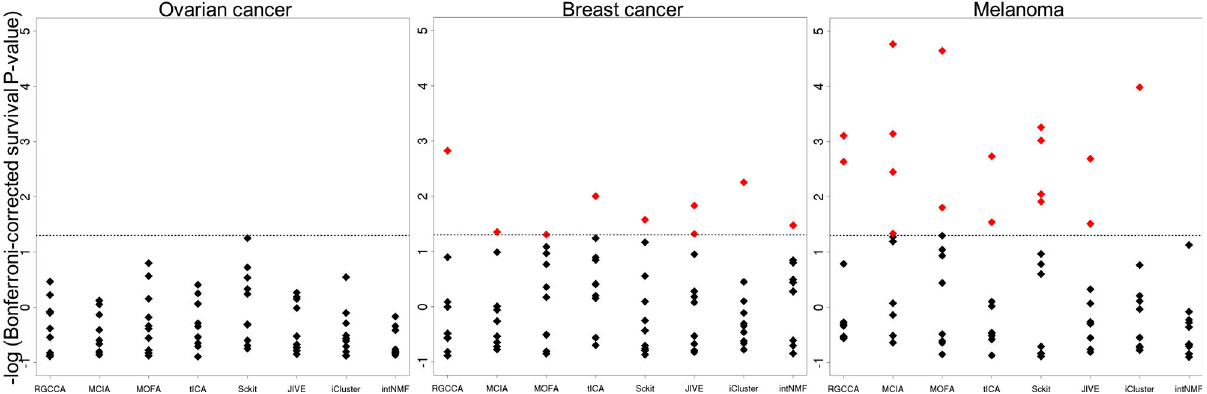
Fig. 5 Identi fi cation of factors predictive of survival in ovarian, breast, and melanoma cancer samples by the jDR methods. For each method the Bonferroni-corrected p-values associating each of the 10 factors to survival (Cox regression-based survival analysis) are reported. The dot lines correspond to a corrected p -value threshold of 0.05. The results corresponding to the other seven cancer types are presented in Supplementary Fig.